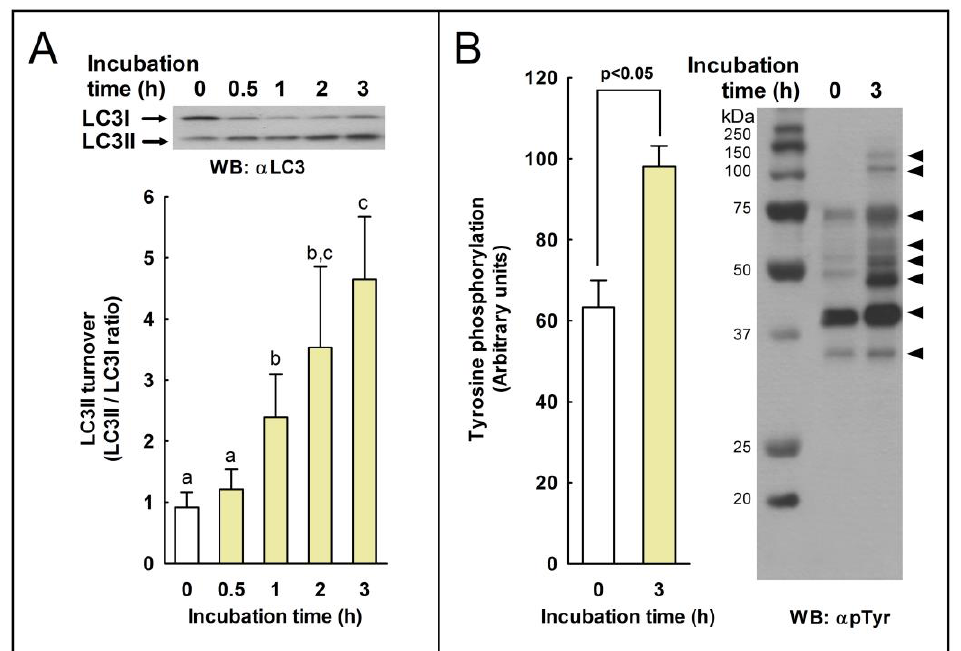
Figure 1. The effect of capacitation in LC3 turnover (LC3II/LC3I ratio) and protein tyrosine phosphoryla- tion in stallion spermatozoa. ( A ) Equine spermatozoa were incubated in capacitating medium (BWW) for up to 3 h at 37 ◦ C. At the indicated times, sperm cells were removed from the incubation vial and immediately lysed. Ten µ g of proteins was loaded and resolved by SDS-PAGE, and immunoblotting was performed with an LC3 antibody ( α LC3). The signal was quantified by densitometry, and LC3 turnover was expressed as the LC3II/LC3I ratio. Values represent the mean ± SEM of 6 independent experiments. Bars with different letters indicate significant differences ( p < 0.05). ( B ) To assess the degree of capacitation, after 3 h of incubation in BWW at 37 ◦ C, sperm cells were lysed in ice-cold lysis buffer supplemented with sodium orthovanadate, and protein tyrosine phosphorylation was investigated by using an anti-phosphotyrosine antibody (clone 4G10) ( α pTyr). The signal was quantified by densitometry. Values on the left represent the mean ± SEM of 6 independent experiments ( p < 0.05). On the right, a representative western blot is displayed. The bands show increased tyrosine-phosphorylation after incubation in capacitating medium (3 h) compared to control, and uncapacitated sperm cells (0 h) are indicated by the arrow heads in the right, showing, from top to bottom, 131, 113, 72, 62, 55, 48, 41, and 35